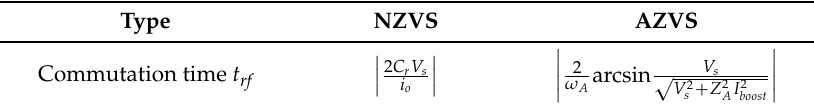
Table 2. The commutation time with different type of